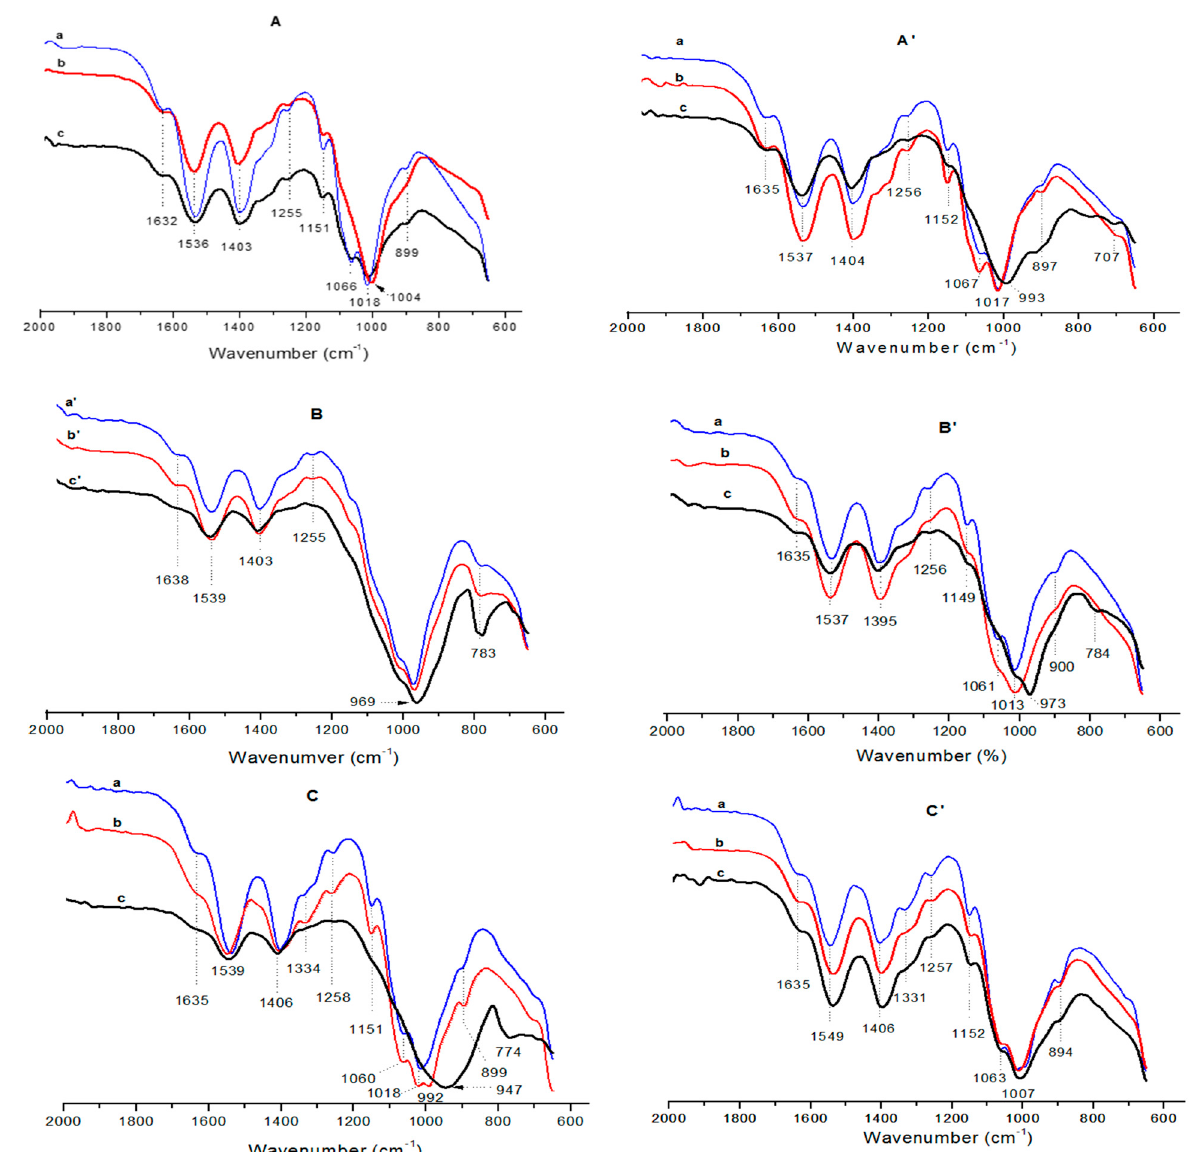
Figure 7. FT-IR spectra of the composite films studied.( A ) montmorillonite-( α -chitosan); ( A’ ) montmorillonite-( β -chitosan);( B ) palygorskite-( α -chitosan); ( B’ ) palygorskite-( β -chitosan);( C ) GCM-( α -chitosan); ( C’ ) GCM-( β -chitosan).( a ) 3 wt.%, ( b ) 5 wt.%, ( c ) 25 wt.%, ( a’ ) 15 wt.%, ( b’ )= c , ( c’ ) 50 wt.%.